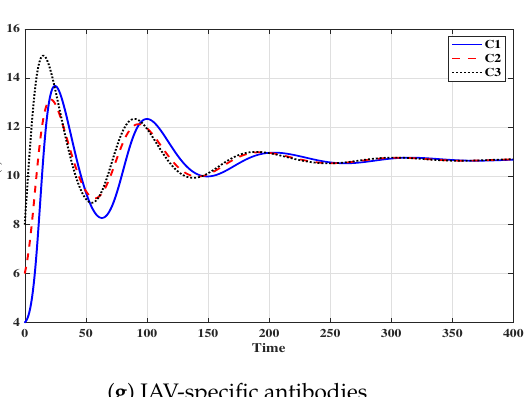
Figure 9. Solutions of system (3) with initials C1–C3 tend to Ξ 7 = ( 5.26,1.2,0.53,0.5,0.4,5.57,10.66 ) when (cid:60) 7 > 1 and (cid:60) 8 > 1 (Situation